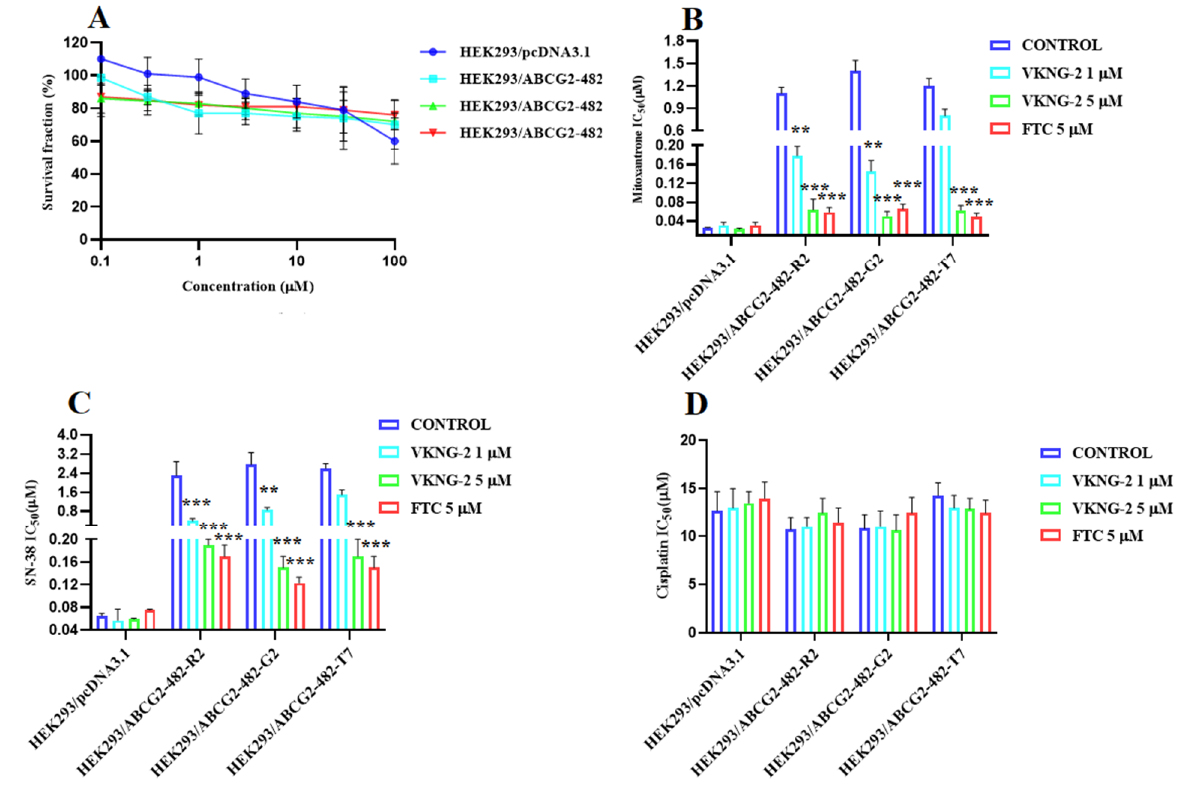
Figure 2. The effect of VKNG-2 in HEK293 cells transfected the gene coding for the ABCG2 transporter. ( A ) The survival fraction (%) for HEK293/pcDNA3.1 (empty DNA vector control), HEK293/ABCG2-482-R2, HEK293/ABCG2-482-G2, and HEK293/ABCG2-482-T7 cell lines was determined following incubation with 5 µ M of VKNG-2 for 72 h. The IC50 values for mitoxantrone following incubation with VKNG-2 (1 or 5 µ M) or FTC (5 µ M) for 72 h in HEK293/pcDNA3.1 (empty DNA vector control), HEK293/ABCG2-482-R2 (HEK293/ABCG2-482-G2 and HEK293/ABCG2-482-T7 cell lines. The IC 50 values of mitoxantrone ( B ), SN-38 ( C ), and cisplatin ( D ) in HEK293/pcDNA3.1 (empty DNA vector control), HEK293/ABCG2-482-R2, HEK293/ABCG2-482-G2, and HEK293/ABCG2-482-T7 cell lines. The points with error bars represent the mean ± SD of independent determinations in triplicate. The figures are representative of three independent experiments. ** p ≤ 0.01 and *** p < 0.001 compared to the control